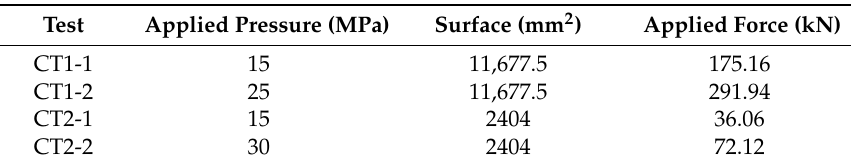
Table 5. Realized compression